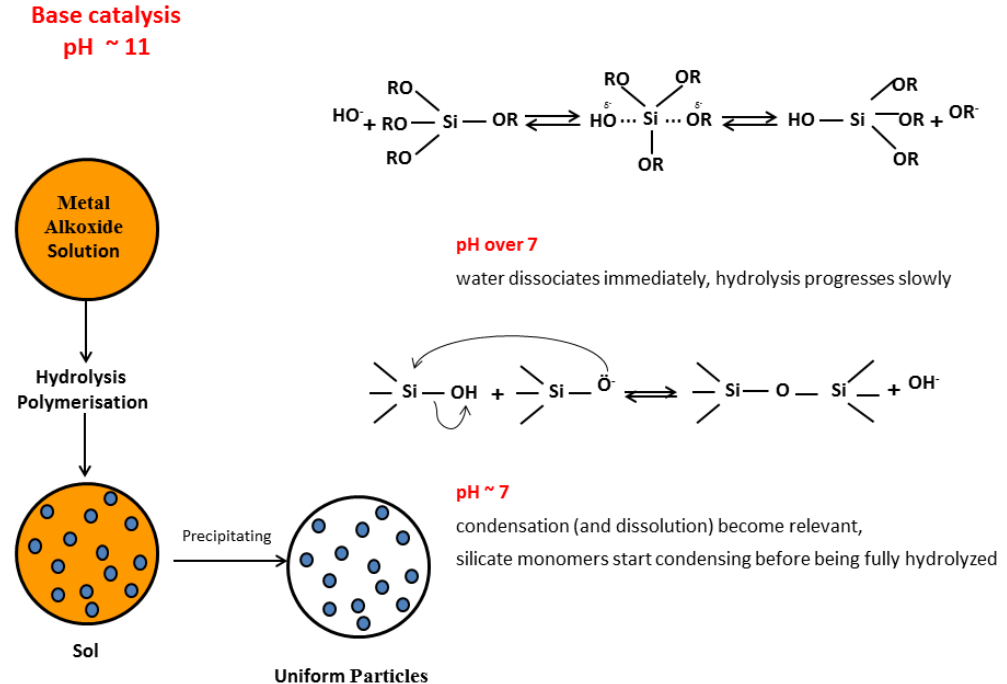
Figure 8. NPs sol-gel Stöber synthesis method.